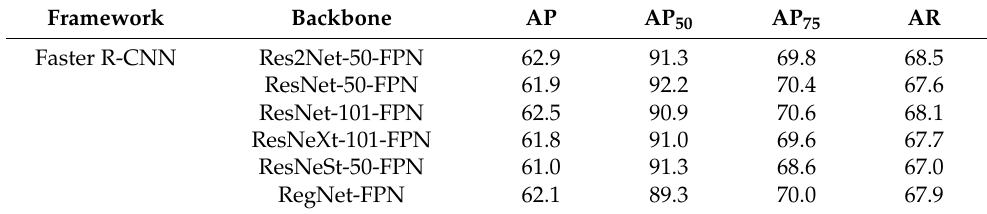
Table 2. Detection results of different feature extraction networks. (unit: